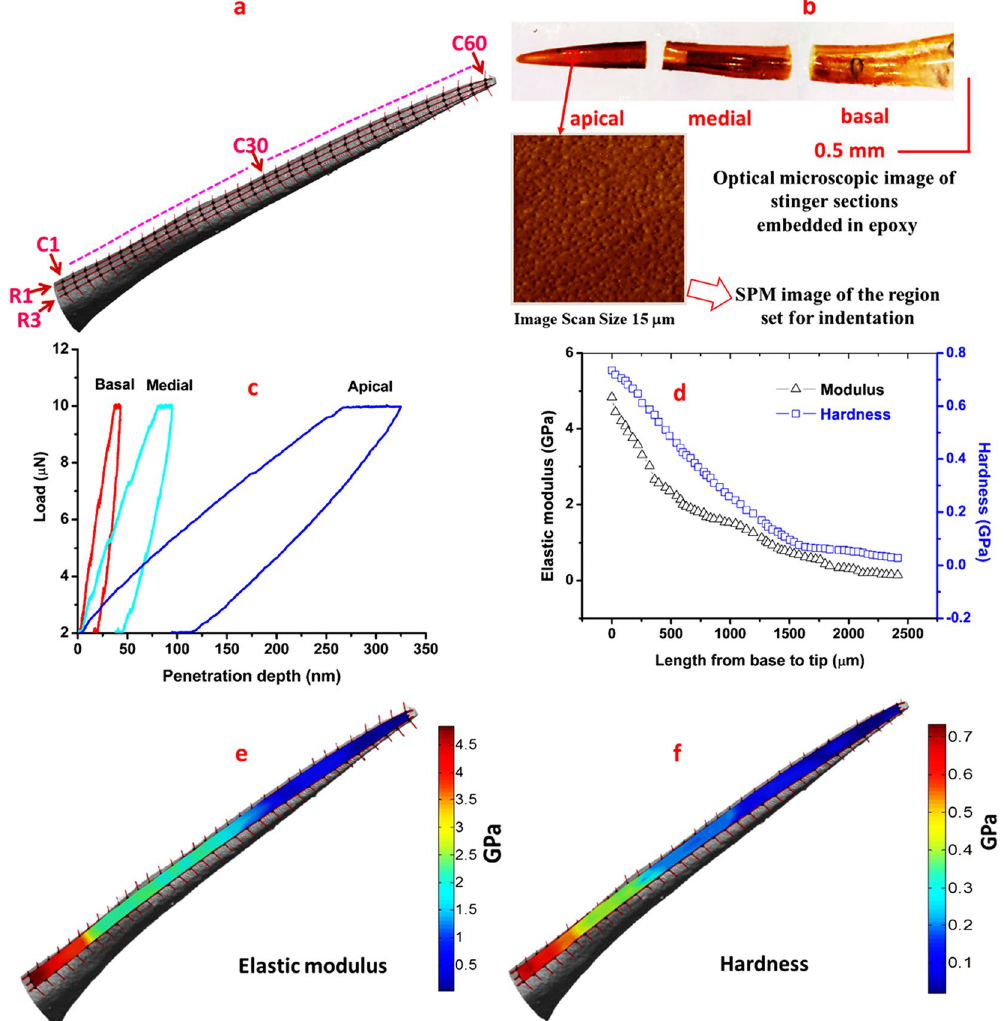
Figure 3. Quasistatic nanoindentation results of wasp stinger ( a ) Approximate sites of nanoindentation on stinger dorsal surface, ( b ) The optical microscopy images of the stinger sections embedded in epoxy and the SPM scan image of apical region used for nanoindentation ( c ) Load versus penetration depth curve at different regions of the stinger, ( d ) Variation of the Modulus and Hardness along the length from base to tip of the stinger, ( e ) Modulus mapping along the length, ( f ) Hardness mapping along the length. [The mapping clearly indicates the mechanical properties reduce along the length from base to tip of the